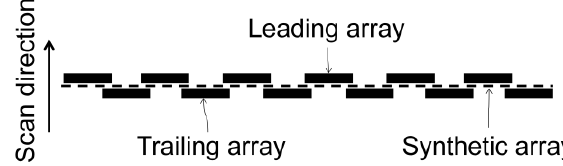
Figure 2. Staggered and synthetic arrays for a spaceborne system